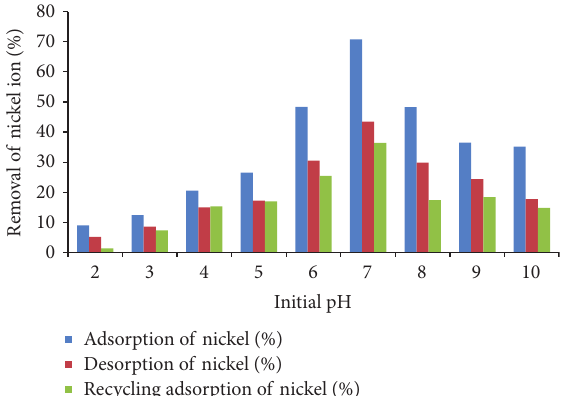
Effect of adsorbent dose